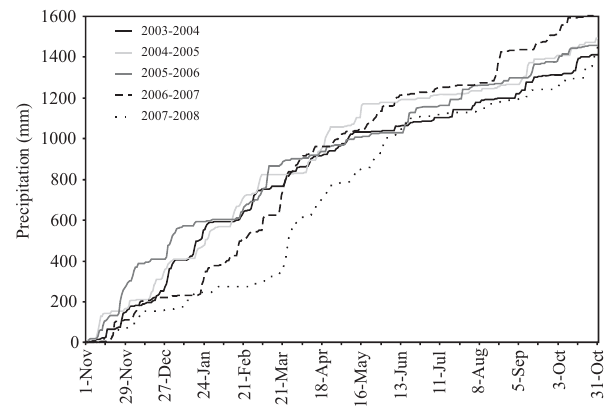
Fig. 3. Accumulated daily precipitation for hydrological years from 2003 to 2008 recorded in Aixola hydrometeorological